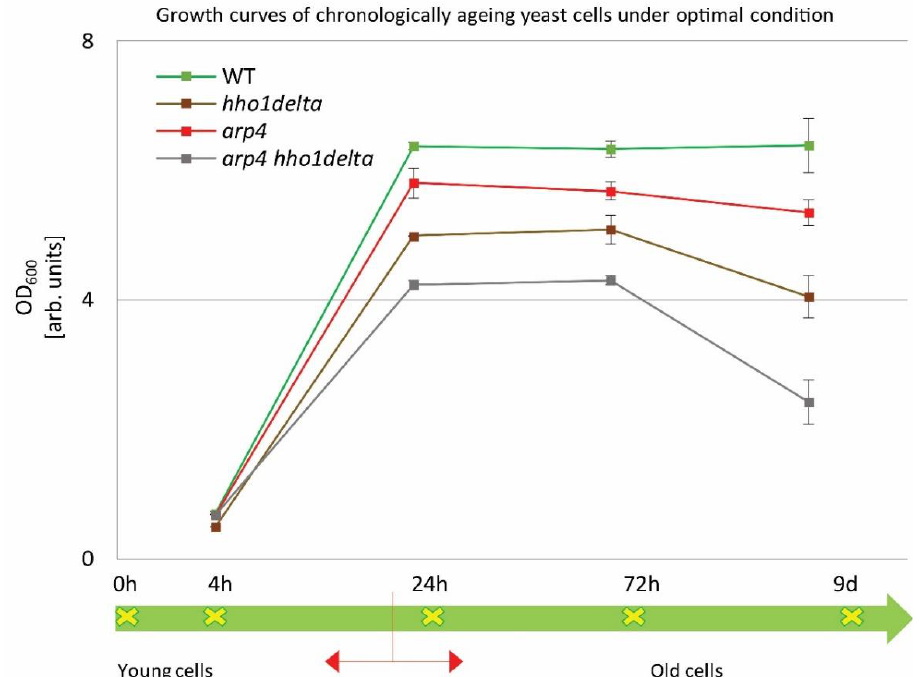
Figure 1. Growth curves of WT, hho1delta , arp4, and arp4 hho1delta yeast cells cultured for a period of nine days under optimal conditions.